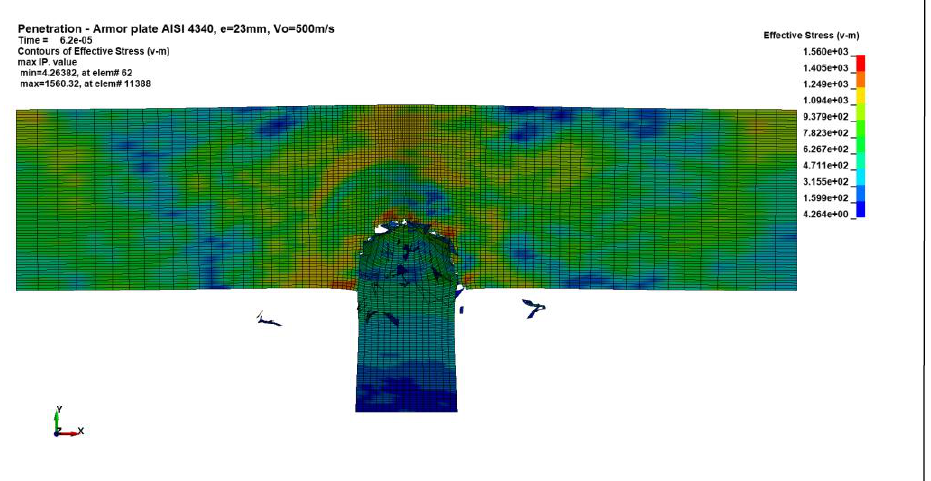
Figure 12 – Von Misses equivalent stress, time of analysis 0.06 ms – Model 2 Рис. 12 – Von Misses эквивалентное напряжение, время анализа 0.06 ms – Модель 2 Слика 12 – Von Misses-ов еквивалентни напон, време анализе 0,06 ms – модел